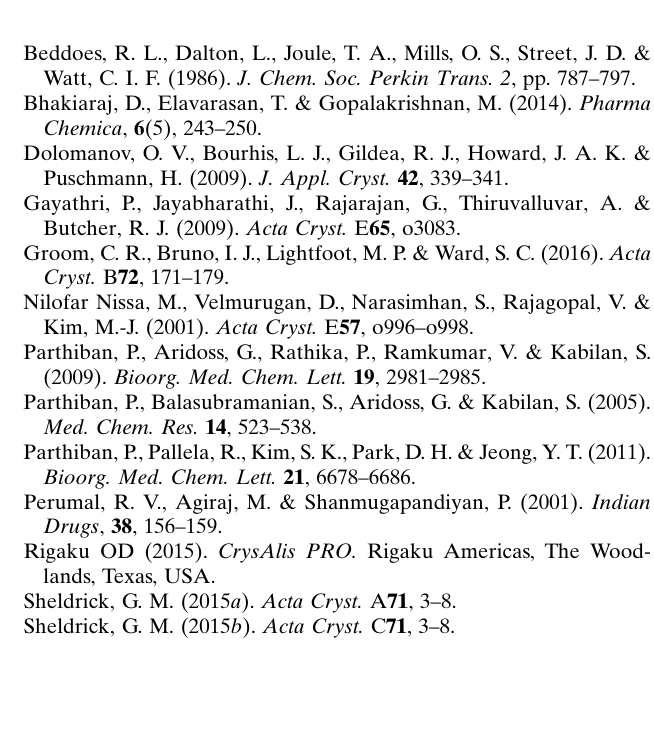
Crystal data Chemical